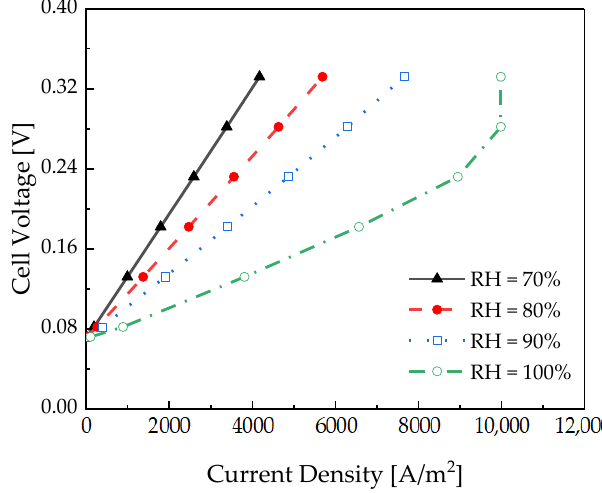
Figure 13. Polarization curve of the pseudo-2D electrochemical hydrogen compressor with respect to the relative humidity.